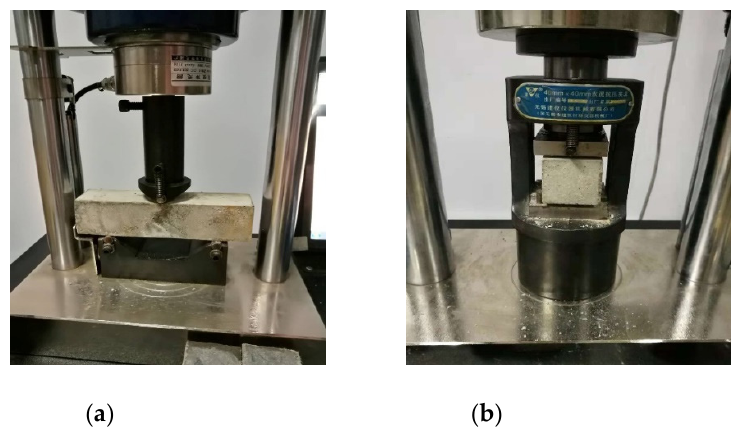
Figure 2. Test photos: ( a ) flexural test and ( b ) compressive test.